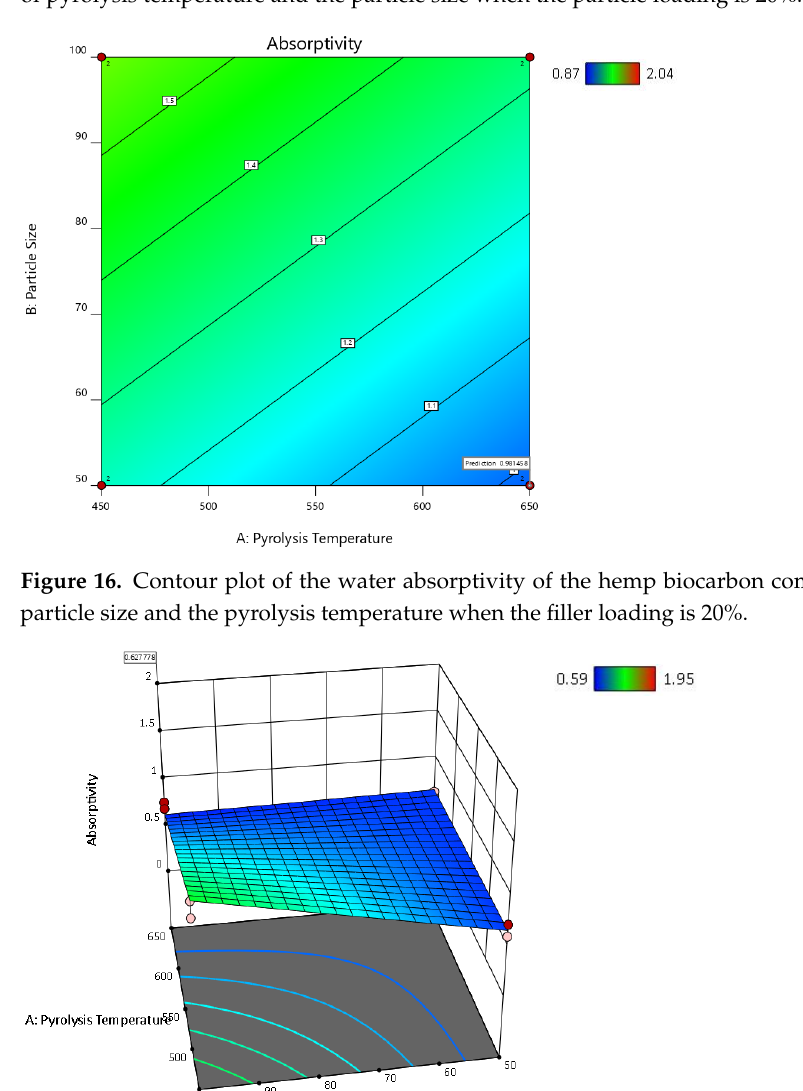
Figure 18. Surface response of the desirability of the water absorptivity of switchgrass biocarbon- filled composites as a function of pyrolysis temperature and particle size when the particle loading is 20%.